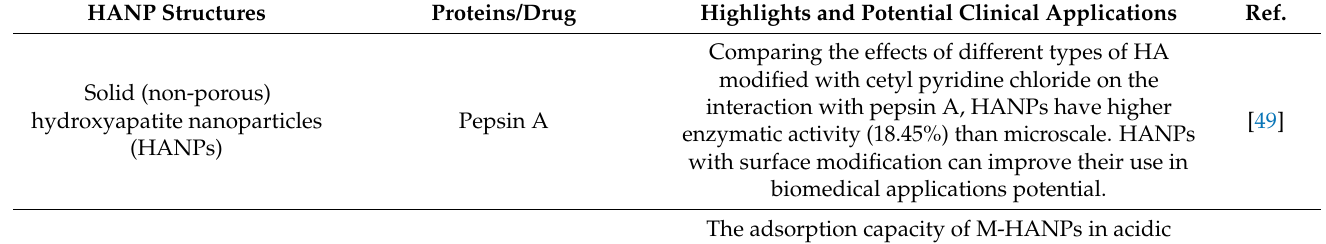
Table 1. Related applications of different types of HANP structures as a template in carrying